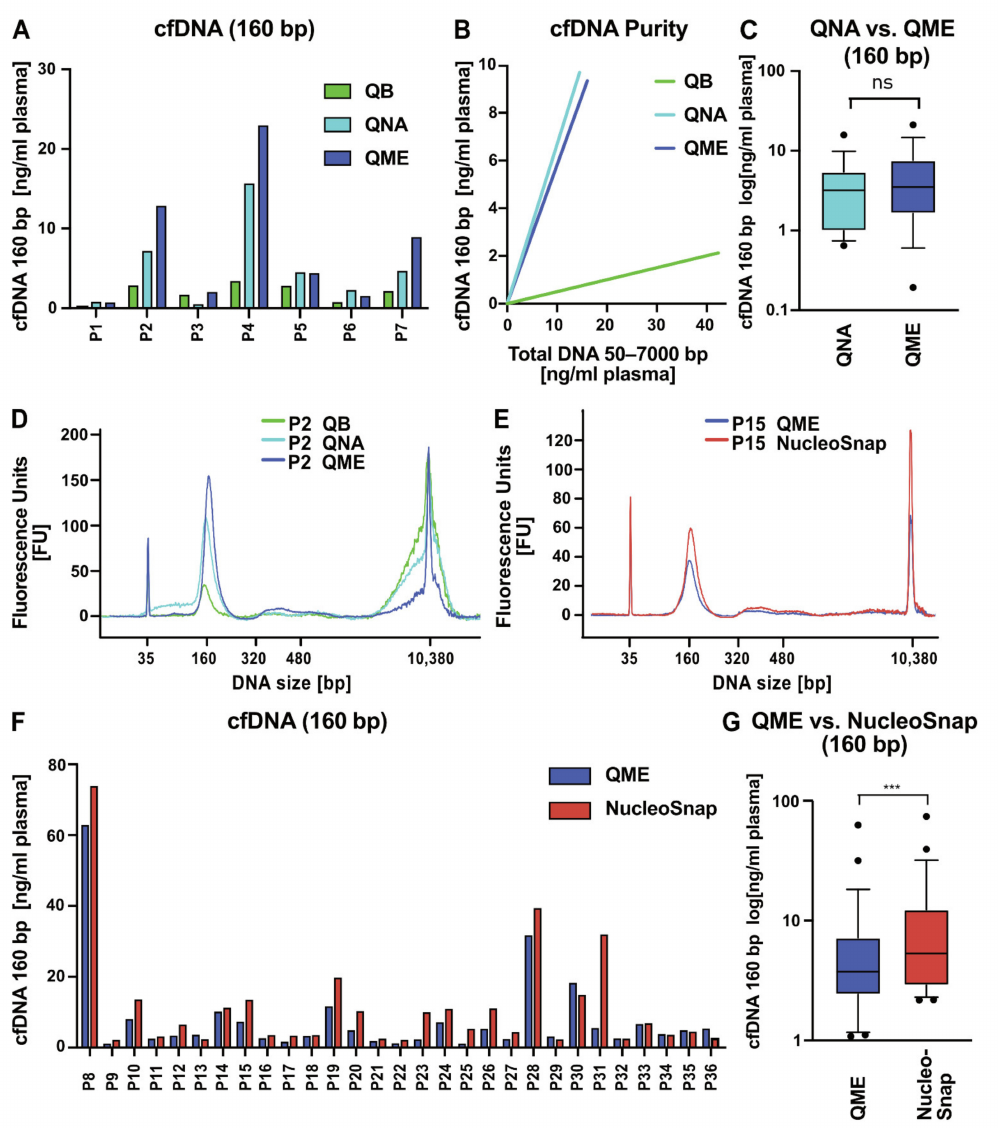
Figure 3. Comparative evaluation of cell-free DNA isolation kit performance concerning yield and purity. ( A ) Direct, paired comparison of QIAamp DNA Blood Mini Kit (QB, green), QIAamp Circulating Nucleic Acid Kit (QNA, light blue), and QIAamp MinElute ccfDNA Mini Kit (QME, dark blue) isolation kits on plasma aliquots of pediatric cancer patients ( n = 7). Cell-free DNA (cfDNA) yields are depicted as the concentration of cfDNA in the first nucleosome peak (160 bp) measured by Bioanalyzer (BA) per millilter of plasma. ( B ) cfDNA purity was defined as the ratio of cfDNA (first nucleosomal peak, 160 bp) to total DNA (50–7000 bp) measured by BA. QB= 0.05; QNA= 0.668; QME= 0.582. ( C ) Plasma aliquots of pediatric cancer patients were isolated with QNA and QME for direct comparison. Logarithmic representation of cfDNA yields measured as first nucleosomal peak (160 bp) by BA. Boxplot shows median and interquartile range, whiskers represent 10th–90th percentiles ( n = 16, p = 0.13). ns denotes differences in means that were not significant as determined by Wilcoxon signed-rank test. ( D ) Representative BA profiles of one plasma sample (P2 cf. Figure 3A) isolated with QB (green), QNA (light blue), and QME (dark blue). ( E ) Representative BA profiles of one plasma sample (P15 cf. Figure 3F) isolated with QME (dark blue) and NucleoSnap (red). ( F , G ) Direct comparison of QME and NucleoSnap isolation kit performance for plasma aliquots of pediatric cancer patients. ( F ) cfDNA yields measured with BA are depicted as the concentration of cfDNA (first nucleosomal peak, 160 bp) per milliliter of plasma. ( G ) Logarithmic representation of cfDNA yields (first nucleosomal peak, 160 bp) by BA. Boxplot shows median and interquartile range, whiskers represent 10th–90th percentiles ( n = 29, p = 0.0005). *** p < 0.001 as determined by Wilcoxon signed-rank